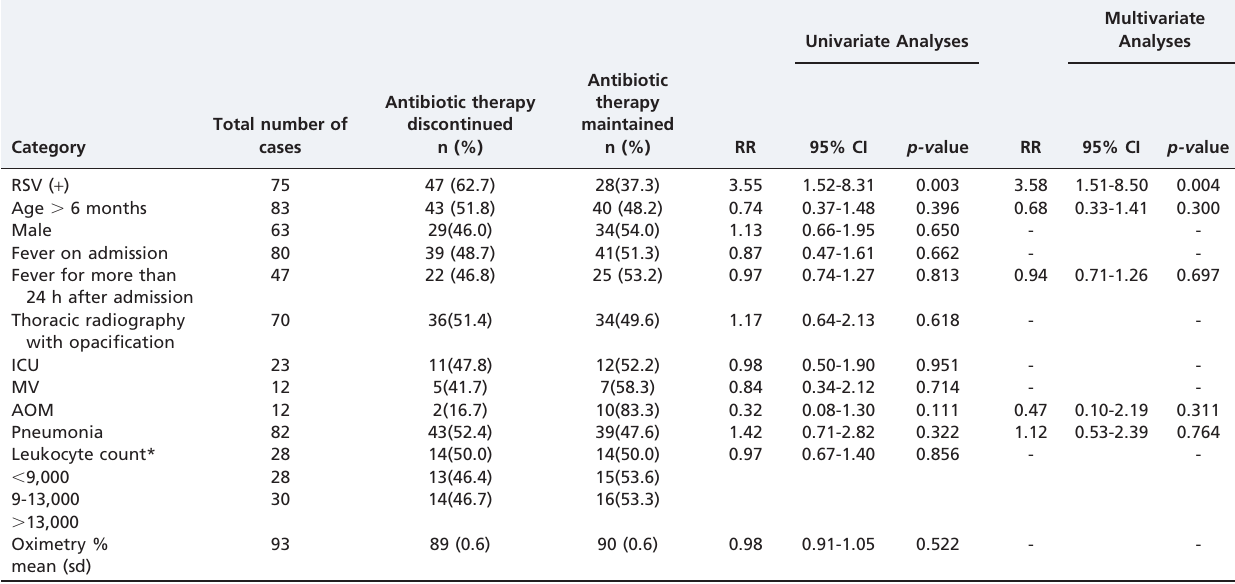
Table 4 - Univariate and multivariate analyses of the possible determinants of the discontinuation of antibiotics during the hospitalization of 109 patients from the VIRUS(-) and RSV( + ) groups who received an initial prescription of antibiotic